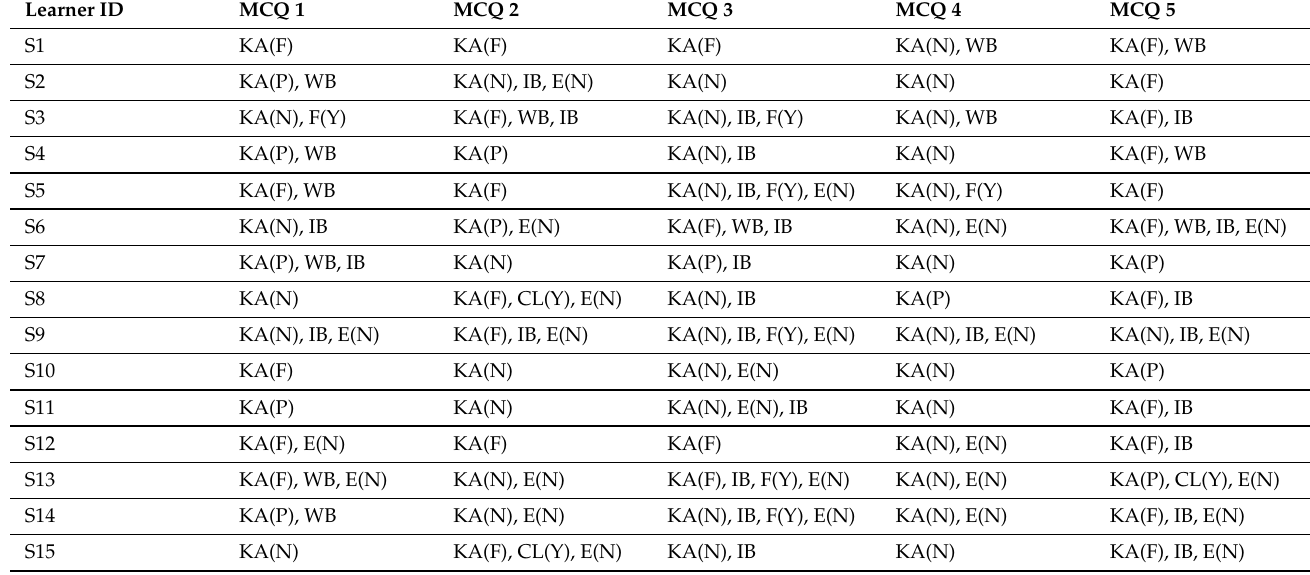
Table 6. Summary of Deeper Insights into each learner’s